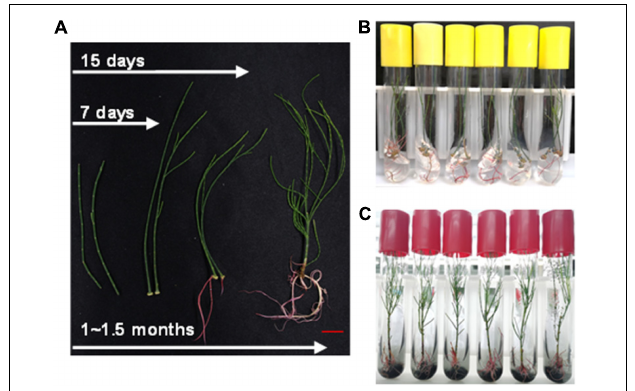
FIGURE 5 | Regenerating system for Casuarina equisetifolia by cutting. (A) Whole process of regenerating system by cutting. (B) Rooting of branchlet in the preferred root medium. (C) Branchlets with young roots were transferred to the basal medium supplemented with activated carbon.